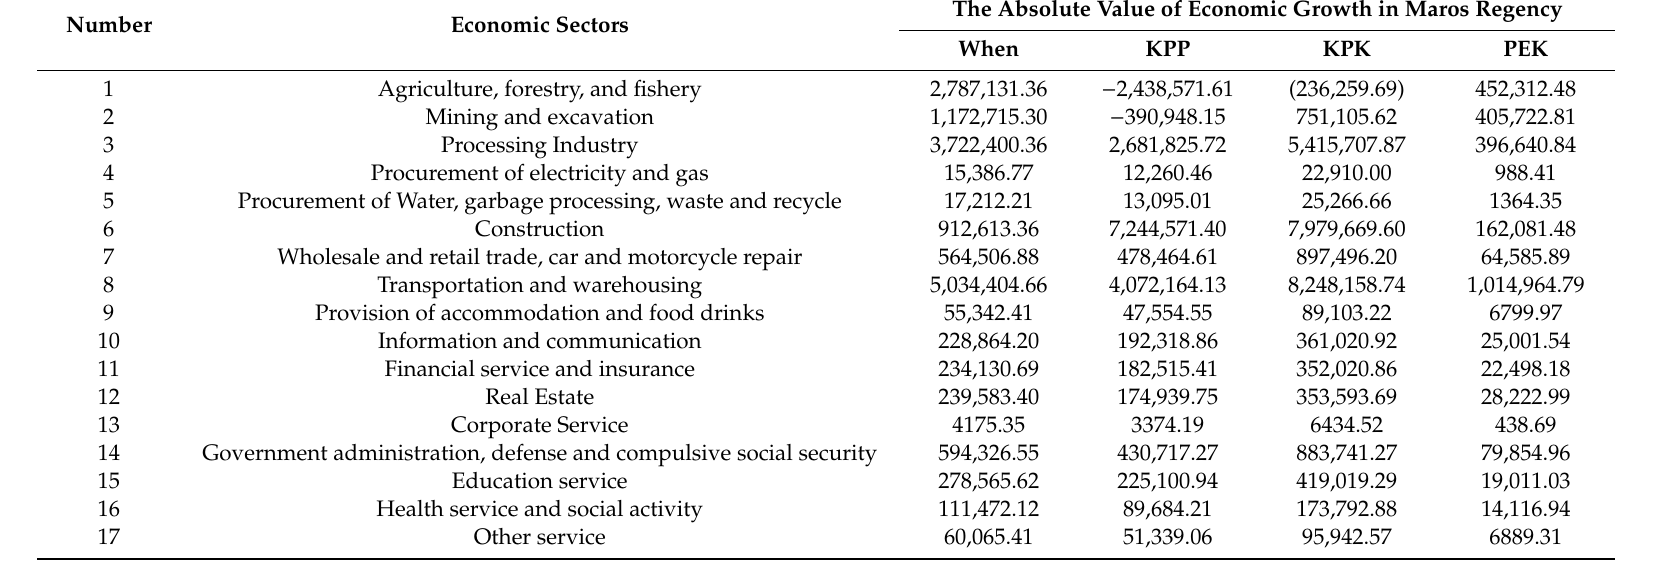
Table A4. Absolute Value of Economic Growth in Maros